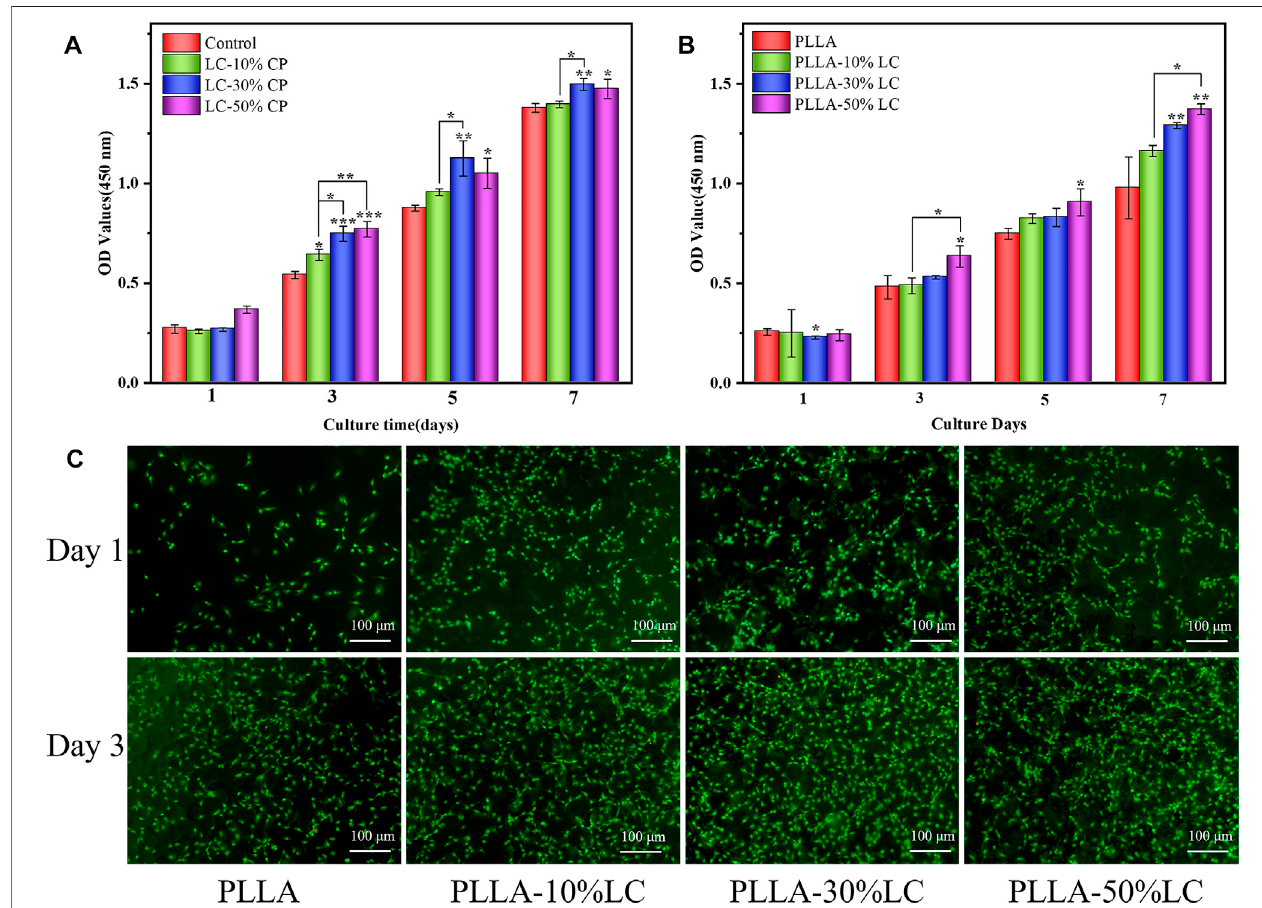
FIGURE2|(A) CellproliferationinCOC/CPLCand (B) PLLA-LCcompositesfor7 days*refertostatisticallysigni fi cantproliferation p < 0.05. (C) AO-EBstainingof MC3T3-E1 cells seeded on pure PLLA, PLLA-10% LC, PLLA-30% LC, and PLLA-50% LC fi